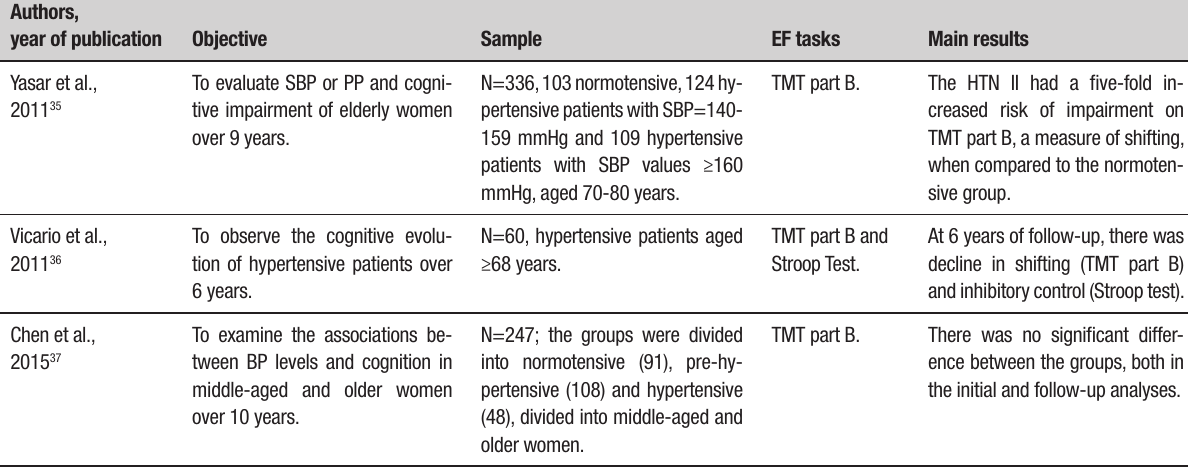
Table 4. Longitudinal studies on EF and SAH.